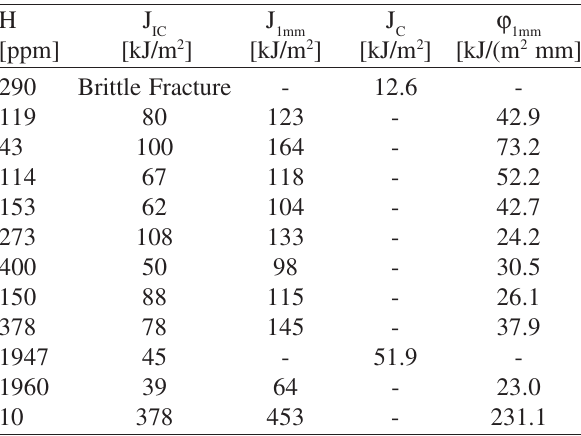
Figure 4. J as a function of hydrogen content. IC